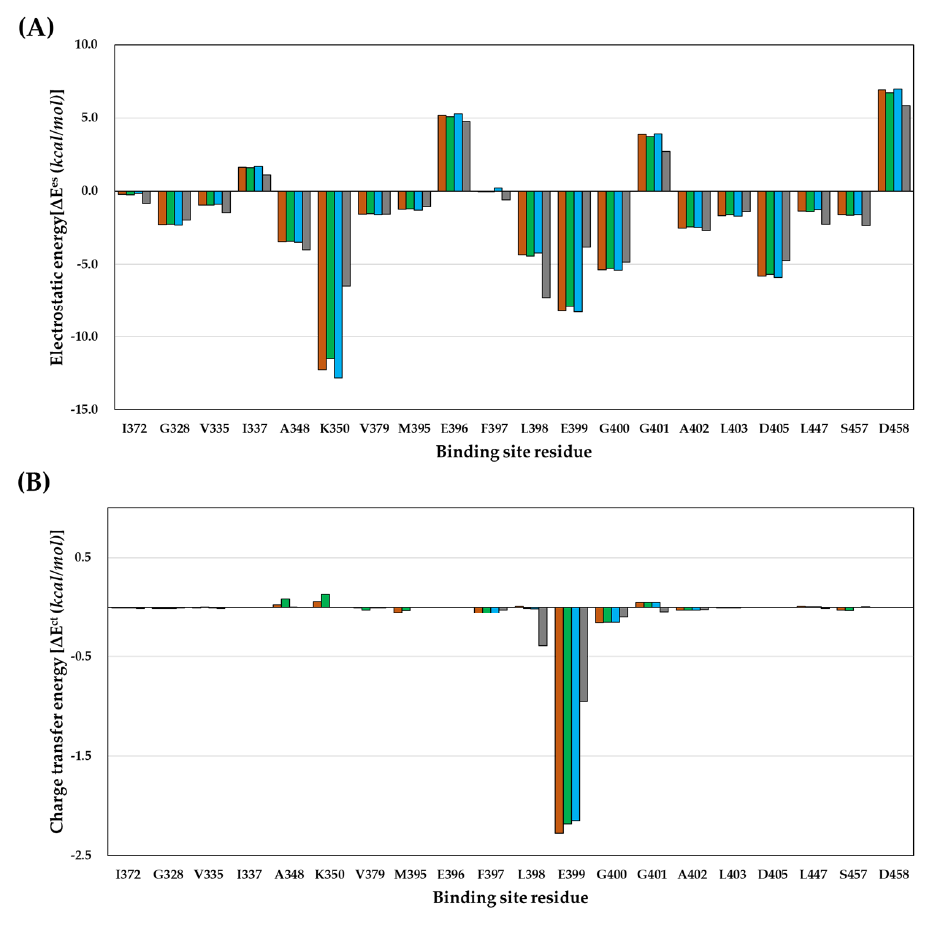
Figure 5. Comparison of calculated energies in the FMO of compound 1–4. (A) Electrostatic energies (E es ), (B) charge transfer energies (E ct ). Compounds 1, 2, 3, and 4 are shown in brown, green, light blue, and gray, respectively.